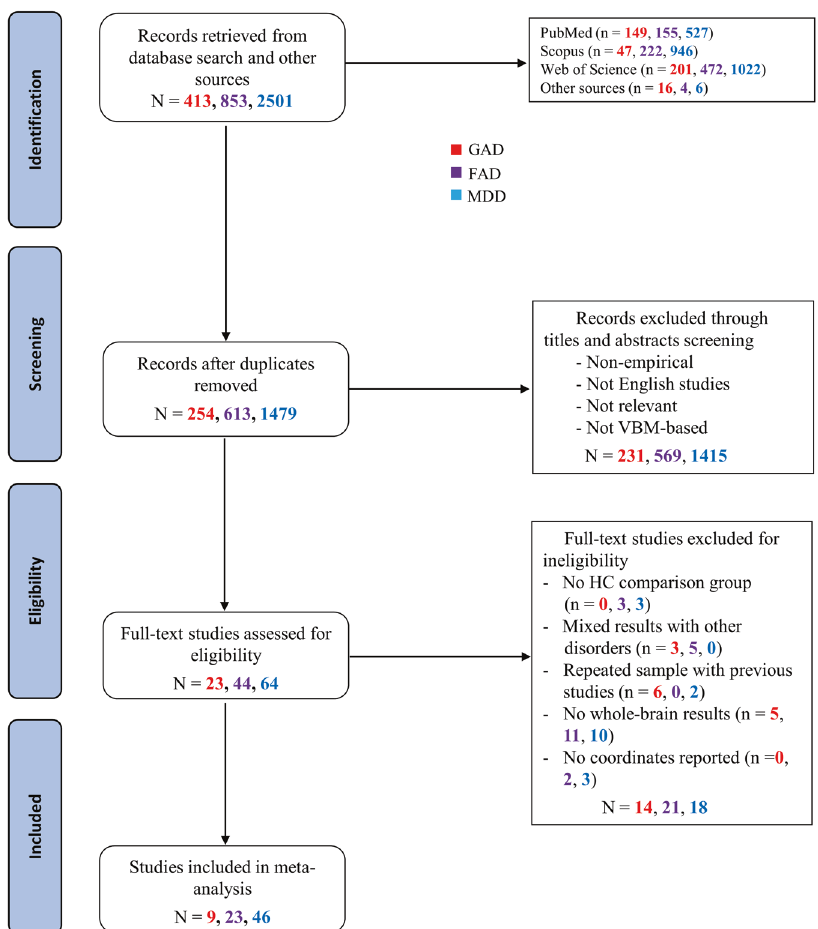
Fig. 1 PRISMA fl ow diagram of study selection in the current meta-analysis. FAD fear-related anxiety disorder, GAD generalized anxiety disorder, HC healthy controls, MDD major depressive disorder, VBM voxel-based morphometry. Note: The Arabic numerals in the fi gure represent the number of studies in each